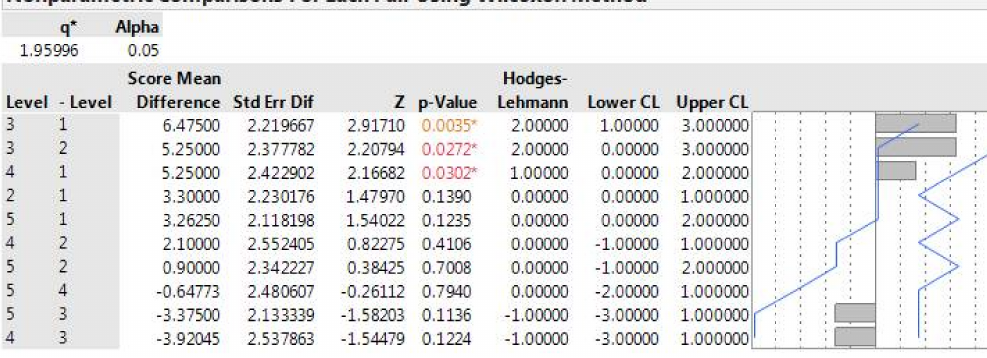
Figure A1. Results from the post-hoc paired Wilcoxon test among ash canopy health classes. Levels 1–5 represent the canopy health classes